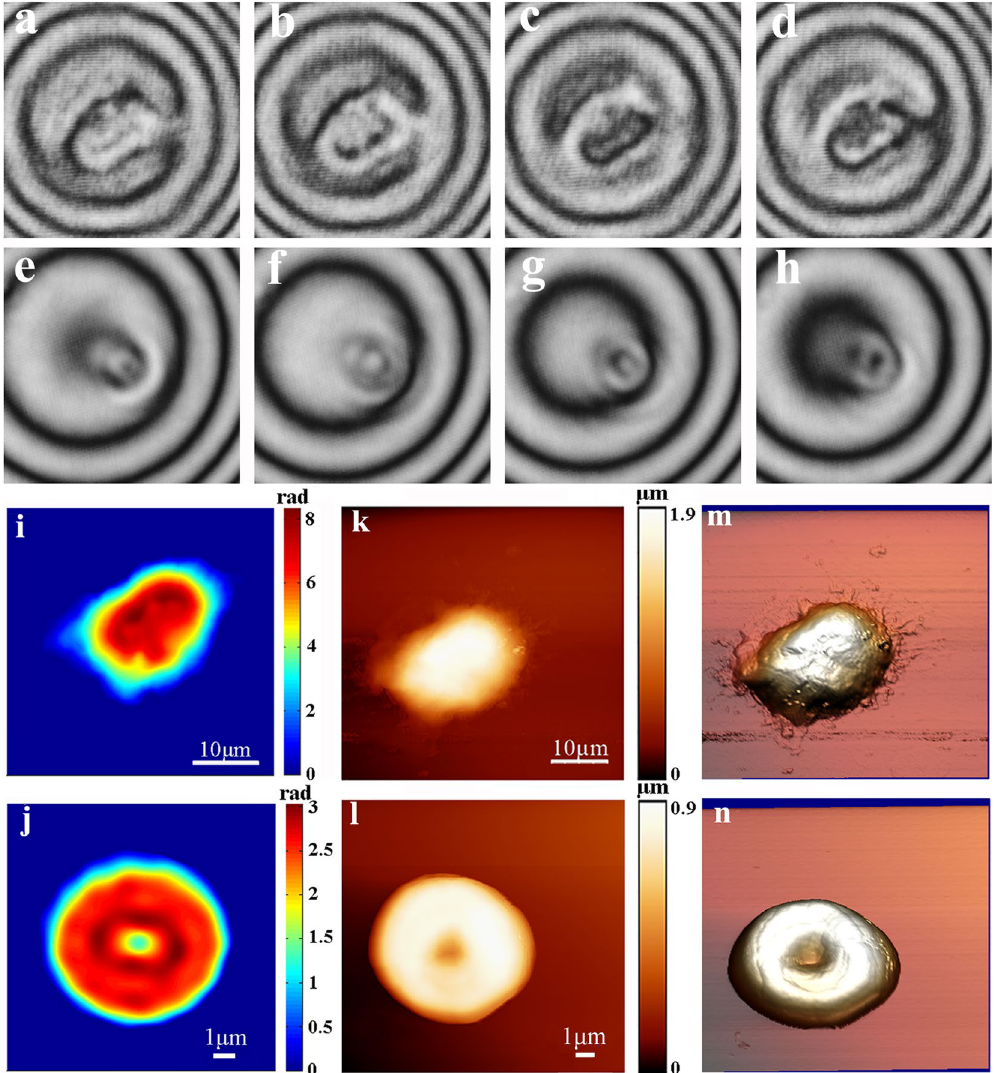
Figure 3. Four-frame phase-shifting Interferograms of Jurkat cell ( a–d ) and RBC ( e–h ) respectively with the phase shifts ( a,e ) 0; ( b,f ) π /2; ( c,g ) π ; ( d,h ) 3 π /2. Phase maps of Jurkat cell ( i ); RBC ( j ); Height distributions of Jurkat cell ( k ) and RBC ( l ); 3D morphologies of Jurkat cell ( m ) and RBC ( n